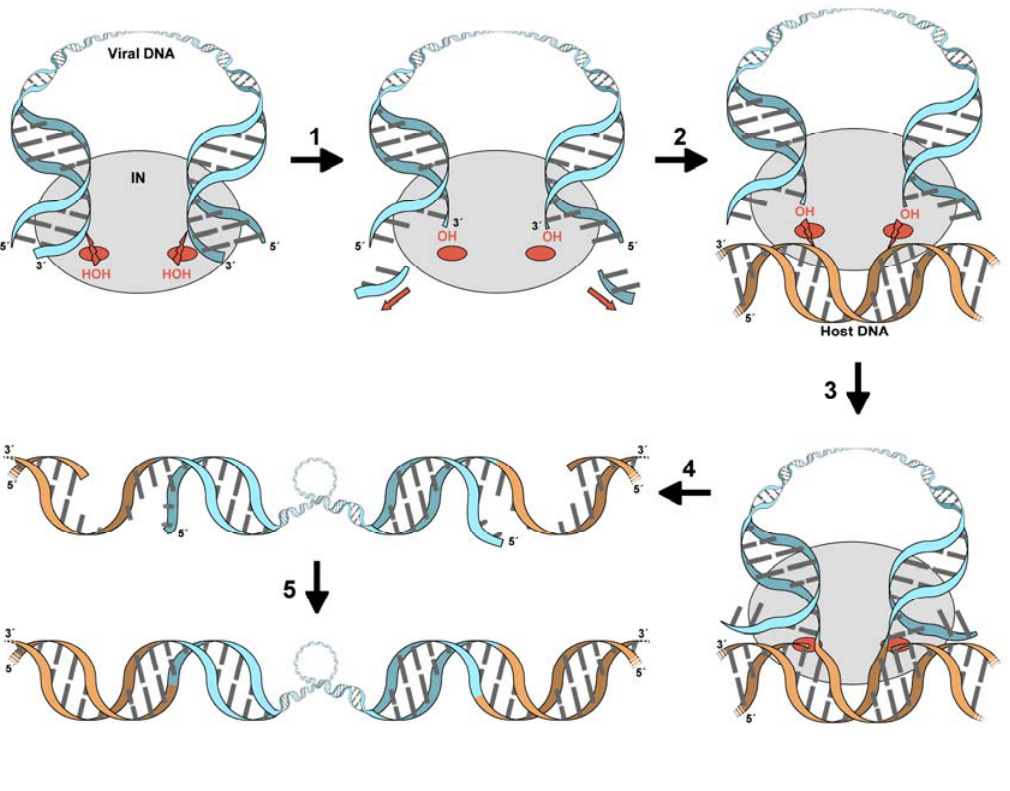
Figure 1. The retroviral DNA integration pathway. The PIC, formed following reverse transcription of the viral RNA genome in the host cell cytoplasm, contains viral DNA (light blue), IN (grey oval), along with other viral and host cell proteins (not shown). Within the PIC, the active sites of IN (red ovals) activate water molecules for nucleophilic attacks on the phosphodiester backbone close to the 3  ends of the viral DNA. This 3  - processing reaction (1) results in the removal of a di- or tri-nucleotide from both 3’ ends of the viral DNA, exposing the reactive 3’ hydroxyl groups attached to invariant CA dinucleotides. Following nuclear import, the PIC comes into contact with host chromosomal DNA (orange) (2). Whereupon, the IN active sites activate the hydroxyl groups at the 3  viral DNA ends to cut a pair of phosphodiester bonds in the opposing strands of chromosomal DNA, 4-6 bp apart (the exact separation depends on the retroviral genus, and equals 5 bp for lentiviruses) (3). The resulting intermediate (4) contains viral DNA joined at each 3’ end to chromosomal DNA, flanked by short gaps and 5’-overhangs. The final DNA repair step (5) that joins the 5  viral DNA ends to the host DNA is presumably carried out by host